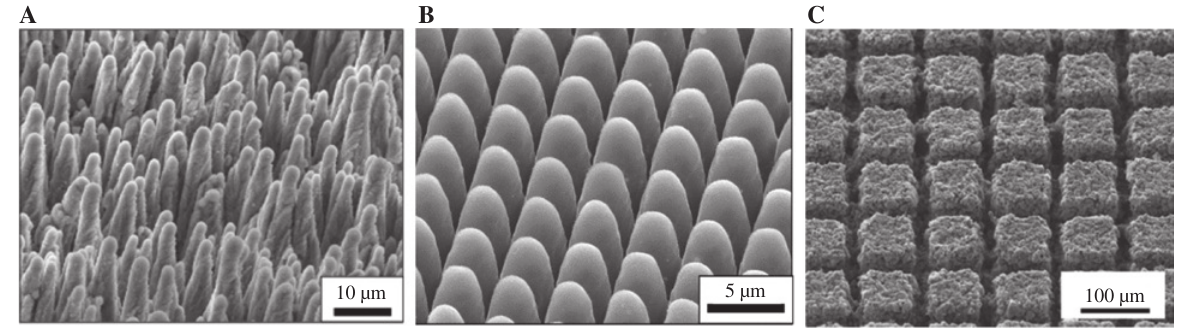
Figure 17: SEM image of microstructures laser-generated in electrode cathode materials: (A) self-organized microstructures in LCO com- posite electrodes by excimer laser exposure, (B) direct excimer laser micropatterning of thin-film LCO electrodes, and (C) micro-pillars in composite LCO electrode obtained by direct fs-laser